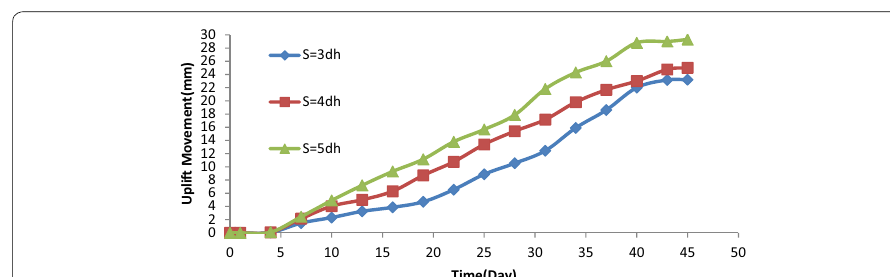
Fig. 29 Variation of uplift movement with time for pile group of L/D